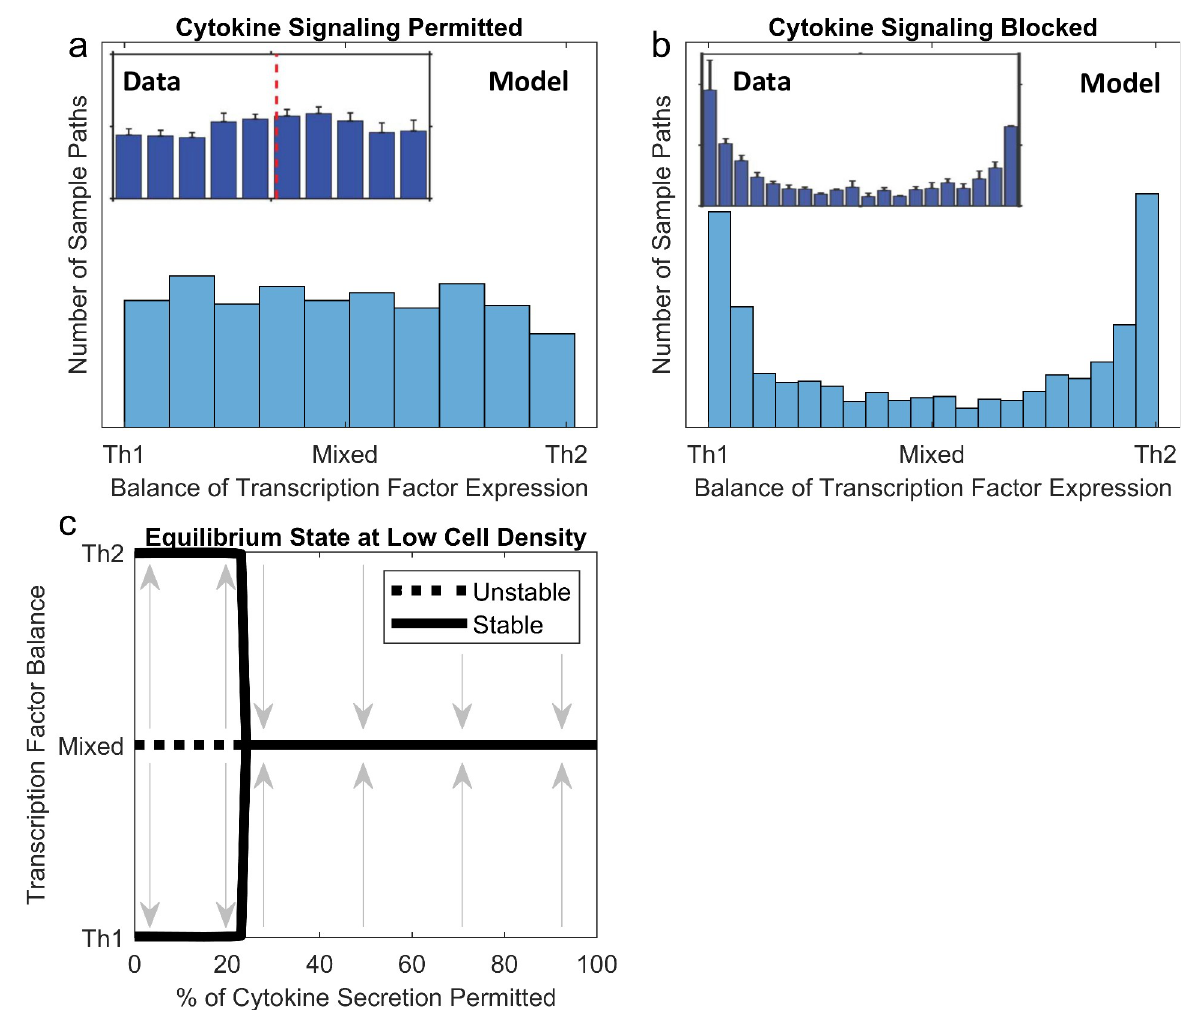
Fig 2. The model captures the distribution of Th effector types in vitro in the presence and absence of cytokine signaling, due to an underlying bifurcation in the dynamical system. All data are from [34]. Experiments and the model were both run at 2 � 10 6 cells/mL. (a) When cytokines accumulate unhindered, a uniform distribution of Th1, Th2, and mixed effector types is observed, as measured by the balance of T-bet and GATA3 expression, across 1000 sample paths of the SDE system. This closely matches empirical observations (inset). (b) When cytokine accumulation is blocked, a U-shaped distribution of Th1 and Th2 effector types is observed across 1000 sample paths of the SDE system. This also closely matches empirical observations (inset). (c) Analysis of the ODE system shows that mixed effector types are only stable in the presence of cytokine signaling. As cytokine secretion is removed from the model, the mixed effector type becomes unstable and bifurcates into polarized Th1 and Th2 effector types.